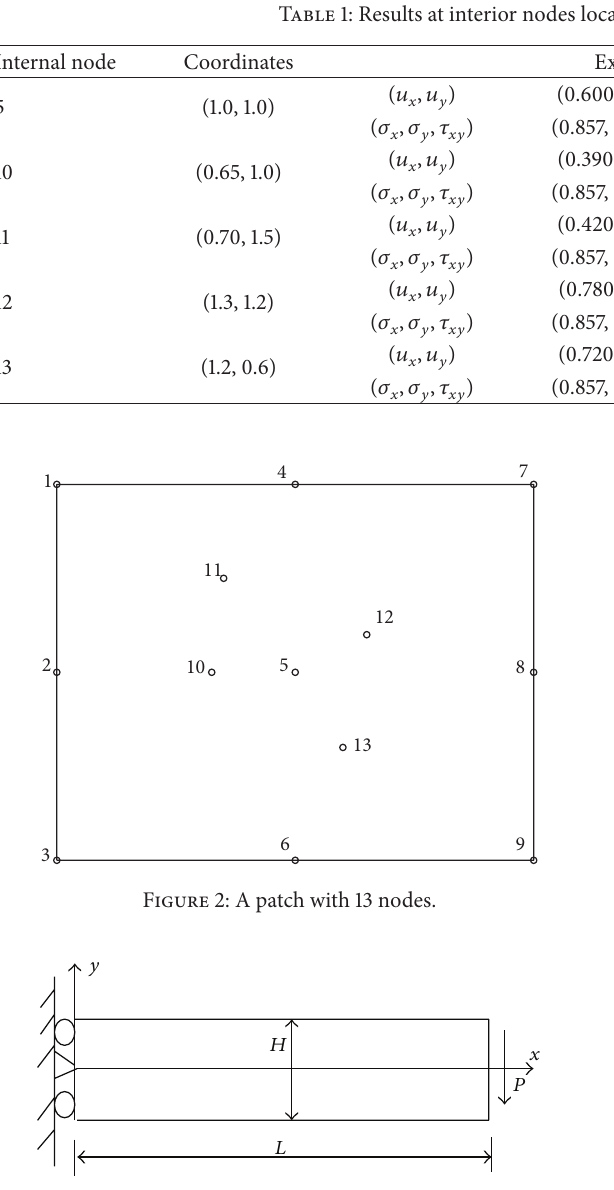
Figure 3: Cantilever